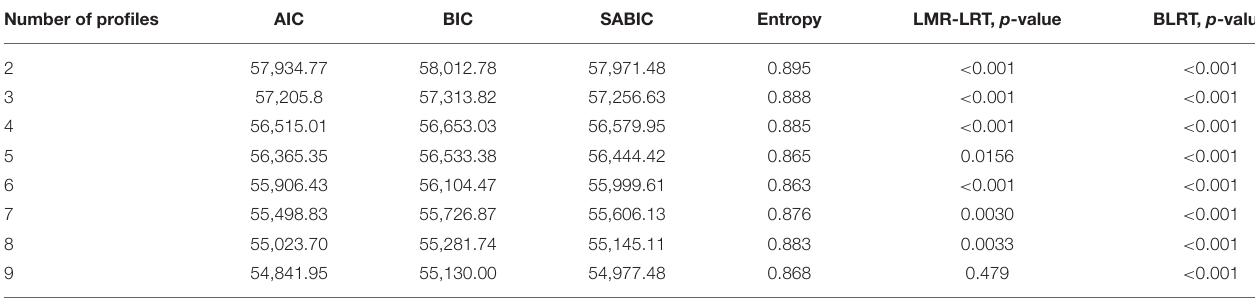
TABLE 3 | Fit indexes of latent profile analysis on Internet and Internet game usage time. Number of profiles